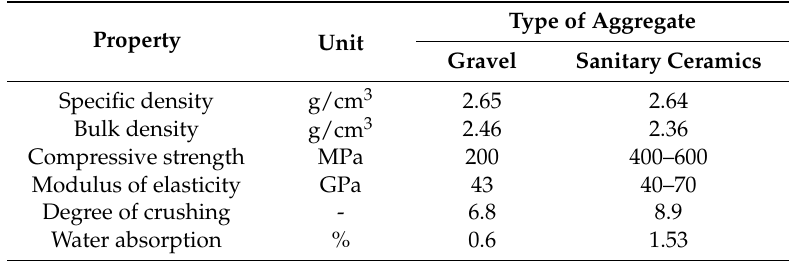
Table 3. Basic properties of aggregates used in the study—gravel and